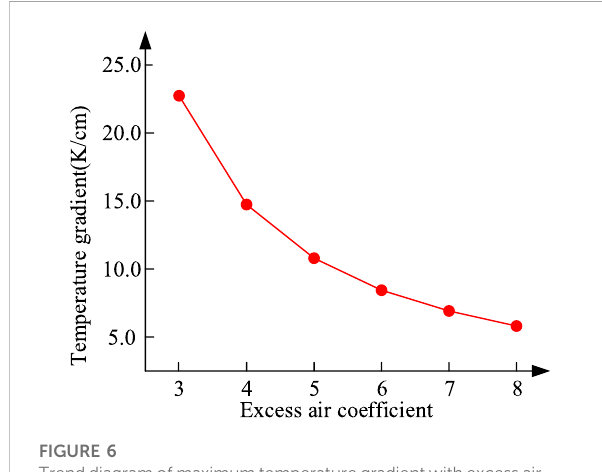
FIGURE 6 Trenddiagramofmaximumtemperaturegradientwithexcessair coef fi cient.